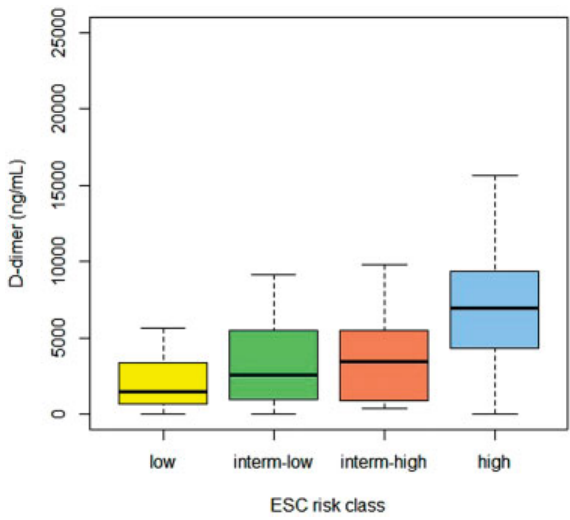
Fig.3 Calibration plotof the predictive model ofdeathwithin 30days since the diagnosis of acute PE. The plot was obtained after 200 bootstrap replicates to correct for optimism. The dashed diagonal line represents the ideal situation when predictive and observed prob- abilities of the outcome exactly coincide (slope ¼